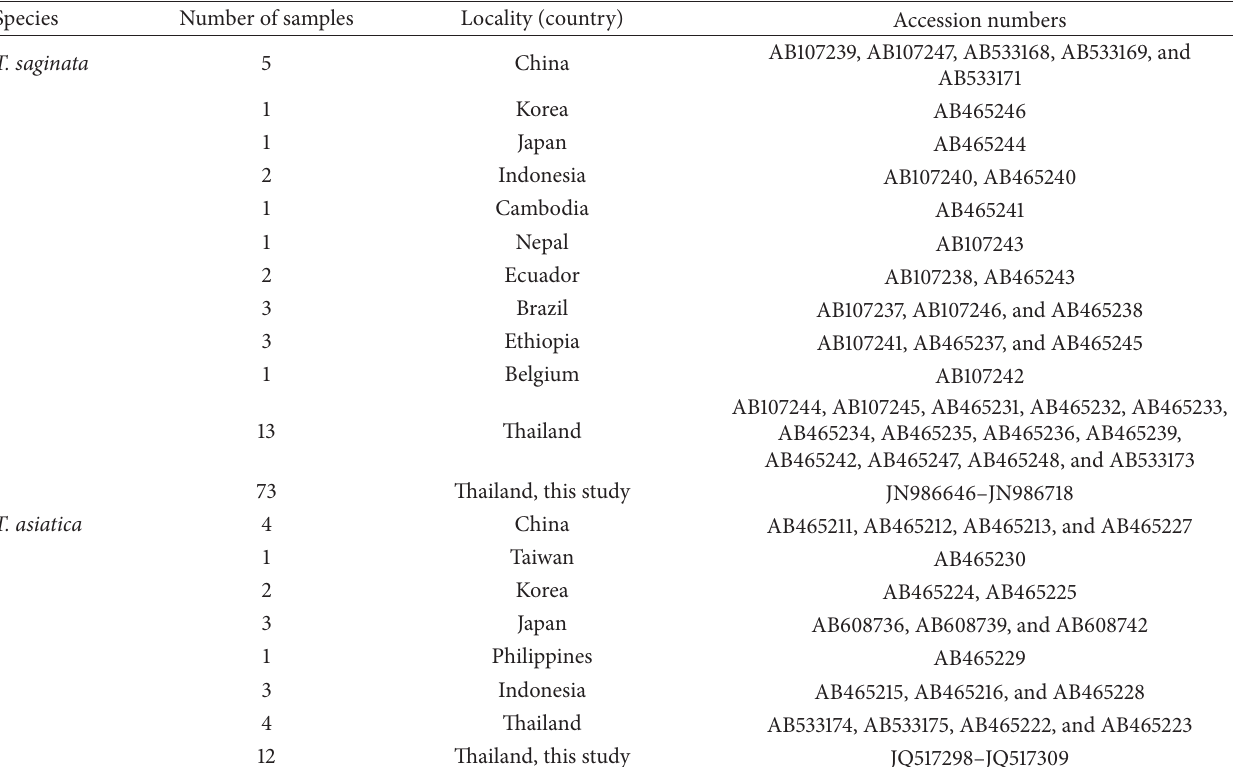
Table 1: Accession numbers of 73 T. saginata cox1 sequences in this study, 33 from 11 different geographical countries, and 30 T. asiatica isolates from 7 different countries deposited in